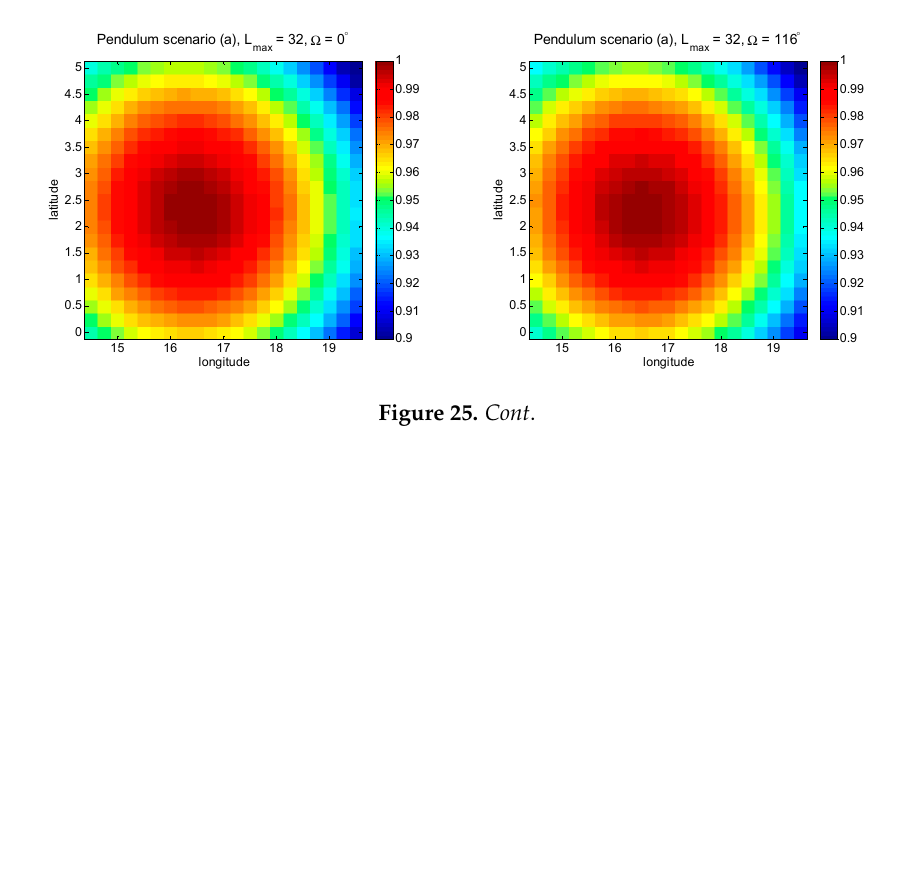
Figure 24. Spatial covariance of a selected point in West Africa (from Figures 19 and 20) for 6-day solution of the inline formation up to L max = MCNR, for top : scenario (a), and bottom : scenario (b). Left is Ω = 0 ° and right is Ω = 116°.